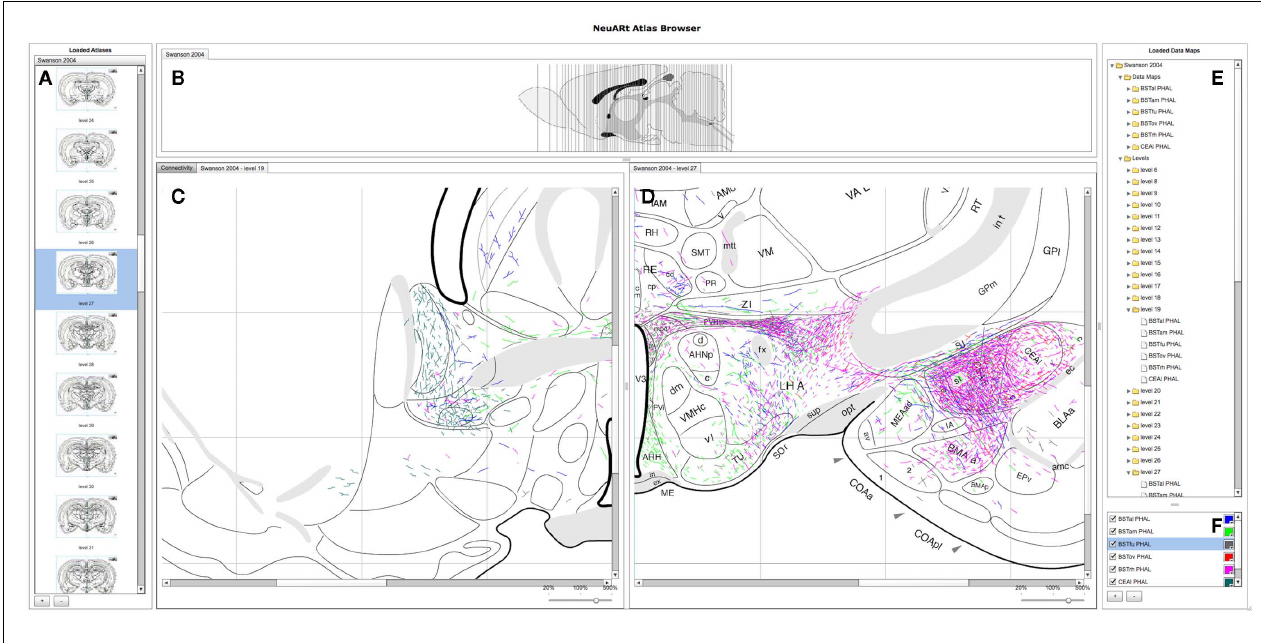
from PHAL injections into the lateral part of the Central nucleus of the Amygdala (CEAl) on the opposite side (Petrovich and Swanson, 1997). (A) Coronal sections for each open atlas in an “accordion” control. (B) A sagittal view of the open atlas (vertical lines are navigable). (C) Level 19 of (Swanson, 1998) in the main, vertically split central panel. (D) Level 27 of (Swanson, 1998) in the main, vertically split central panel. (E) List of the loaded data maps. (F) Control for selecting the maps to show and their color